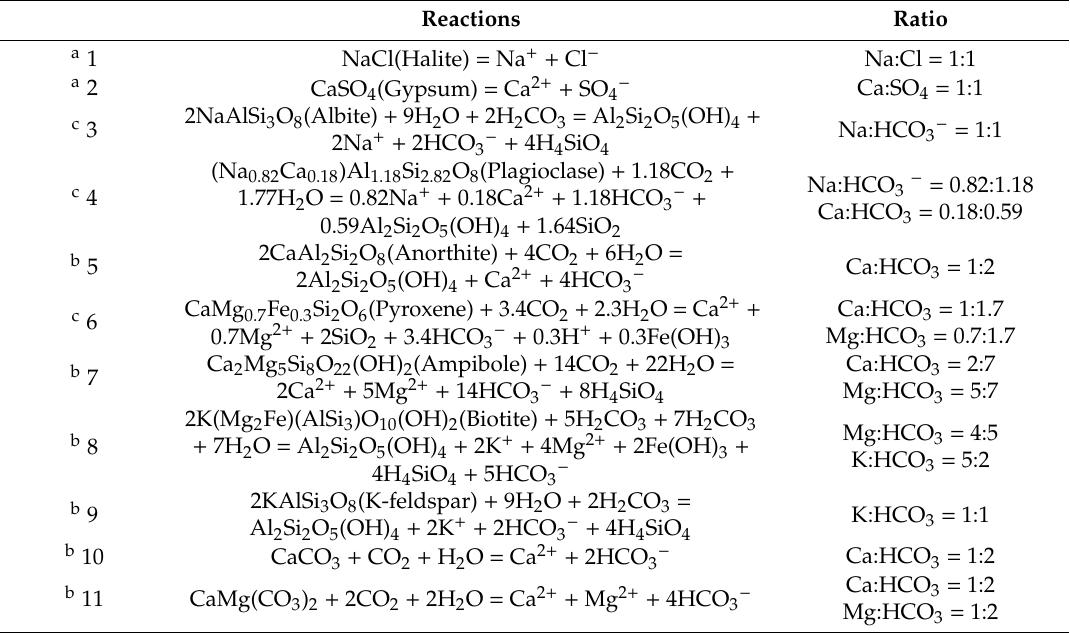
Table 3. Weathering of minerals reactions and ions ratio in the groundwater. Reactions